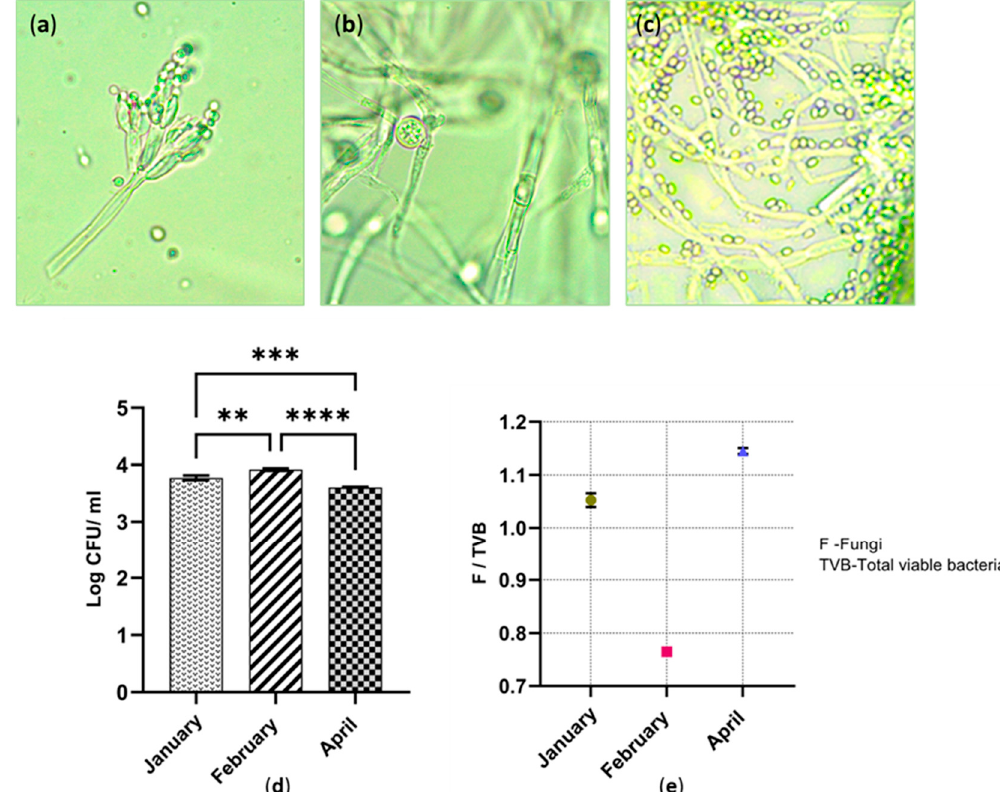
Figure 4. ( a ) Image of Penicillium spp. conidia-bearing structures under light microscope (10 × 100); ( b ) Image of spores inside sporangia under light microscope; ( c ) Image of Trichoderma spp. spores under light microscope (10 × 100); ( d ) Fungal population across the three cutaway sites; ** p ≤ 0.01; *** p ≤ 0.001; **** p ≤ 0.0001; ( e ) The ratio of fungi to viable bacteria in each cutaway site.